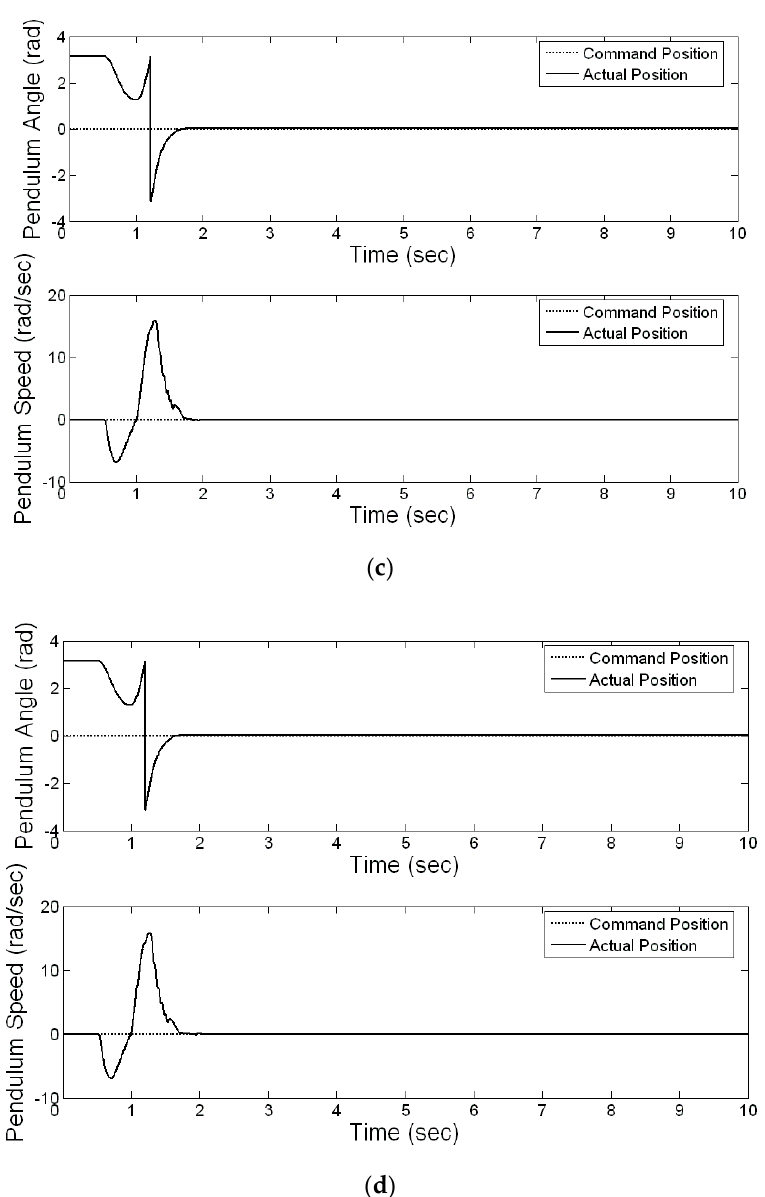
Figure 12. Regulation comparisons of ( a ) proposed IPSO-based NNC, ( b ) PID controller, ( c ) PSO-based NNC, and ( d ) GA-based NNC.